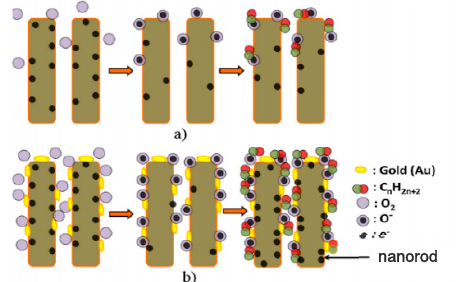
Figure 20. Schematic diagram of gas sensing ( a ) unsensitized nanorods ( b ) Au-sensitized nanorods [53].